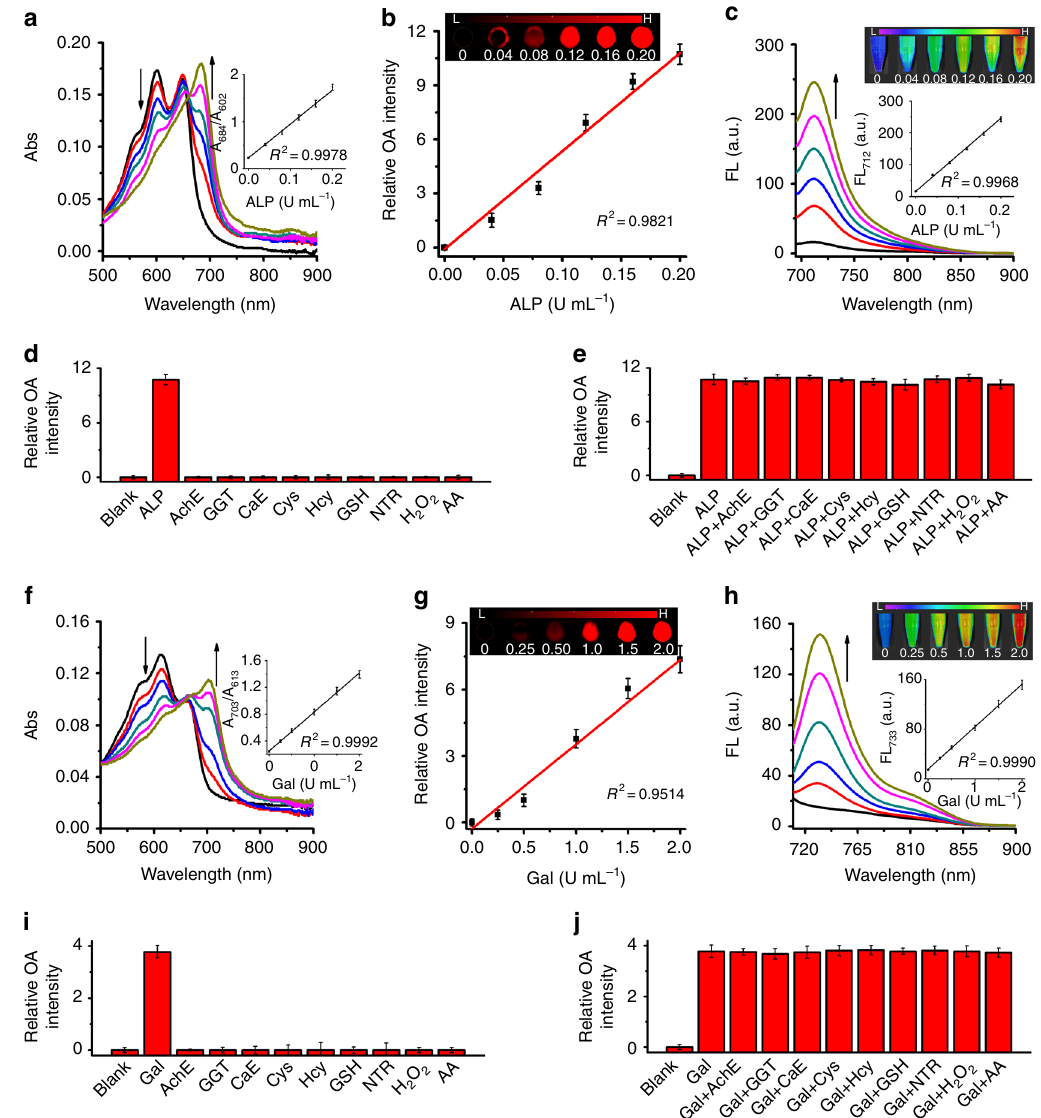
Fig. 2 Optical responses of C 1 X-OR 1 to ALP and C 2 X-OR 2 to Gal in buffers. a and f Absorption spectra for the probes (5 μ M) upon incubation with varied concentrations of corresponding biomarker (0 – 0.2 U mL − 1 for ALP and 0 – 2 U mL − 1 for Gal). The insets show the plots of absorbance ratio vs. biomarker concentration. b and g Optoacoustic response of the probes to corresponding biomarker of varied concentrations (ALP: 0 – 0.2 U mL − 1 , Gal: 0 – 2 U mL − 1 ) ( n = 3). The insets show the representative optoacoustic image of the probes in phantom at varied biomarker concentrations (excitation for b and f is 684 nm and 703 nm respectively). c and h Fluorescent spectra for the probes (5 μ M) upon incubation with corresponding biomarker of varied concentrations (ALP: 0 – 0.2 U mL − 1 , Gal: 0 – 2 U mL − 1 ). The insets show the plots of fl uorescence intensity vs. biomarker concentration. d and i Optoacoustic response of the probes (5 μ M) in the presence of 0.2 U mL − 1 ALP (1 U mL − 1 β -galactosidase) or a potential interference substance. e and j Optoacoustic response